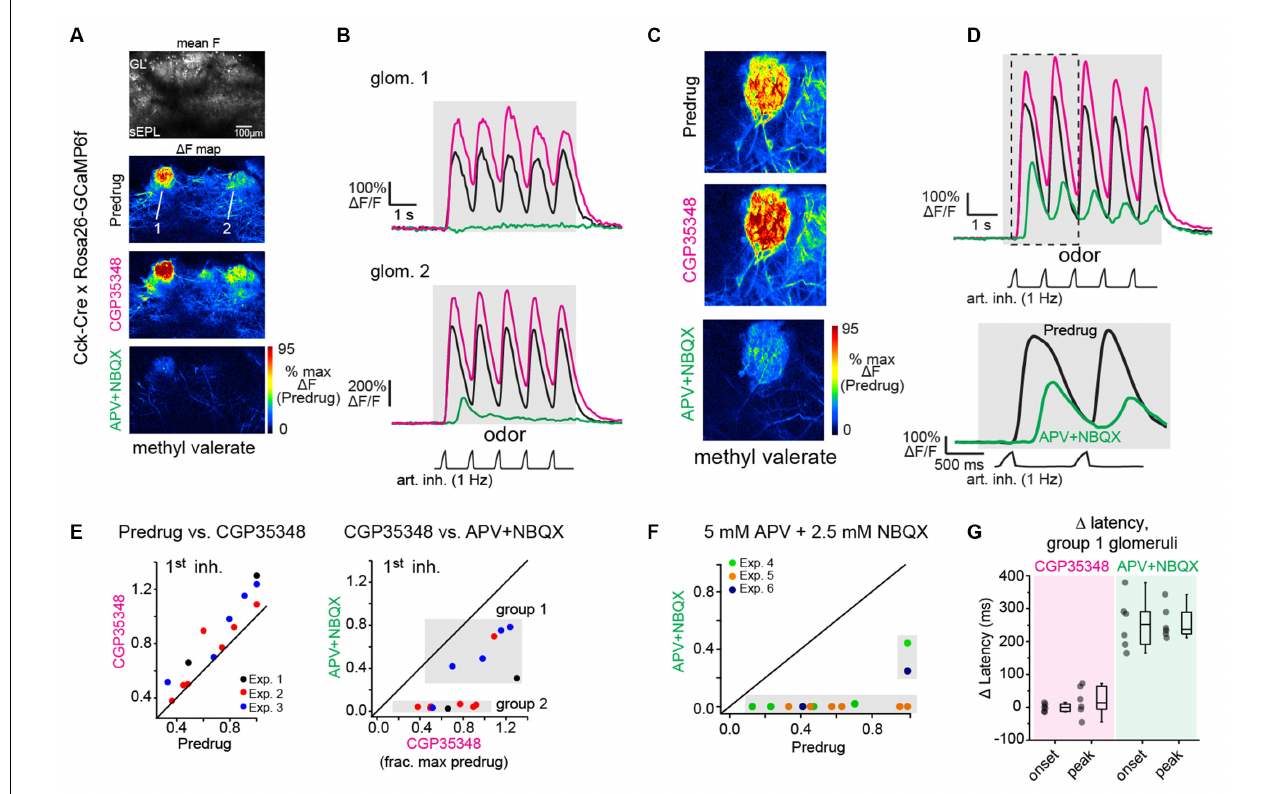
FIGURE 3 | Near-complete blockade of odorant-evoked excitation of CCK+ superficial tufted cells by APV+NBQX. (A) Odorant response maps of GCaMP6f signals imaged from CCK+ superficial tufted cells, taken across Predrug, CGP35348, and APV+NBQX conditions, scaled to Predrug response levels. (B) Response traces for the two glomeruli indicated in (A) , showing enhanced response amplitudes after application of CGP35348 and either elimination (top) or sharp reduction (bottom) in responses after subsequent application of APV+NBQX. Note that in ROI 1, the response after APV+NBQX is eliminated whereas, in ROI 2, the remaining response is present but delayed. Note also the two-fold difference in scale for ROI 2 due to differences in overall response magnitude. (C) Example of high-zoom imaging of GCaMP6f signals imaged from superficial CCK+ neurons innervating a glomerulus, with response maps in Predrug, CGP35348, and APV+NBQX conditions. (D) Traces showing odorant-evoked response from glomerular neuropil in (C) . CGP35348 increases response amplitudes. APV+NBQX decreases response amplitude, with delay in remaining signal relative to inhalation. Lower traces show the expansion of response to the first two inhalations of odorant, highlighting delayed GCaMP6f response after APV+NBQX. (E) Comparison of CCK+ GCaMP6f responses across CGP35348 and subsequent APV+NBQX conditions, imaged from 14 glomeruli in three OBs (two mice). Scatter plots show peak response to first inhalation of odorant in Predrug compared to CGP35348 condition (left) or CGP35348 and APV+NBQX conditions (right). Shaded regions in APV+NBQX vs. CGP35348 plot (upper right) indicate two groups of glomeruli defined by the magnitude of response reduction by APV+NBQX (see Text). Group 1 defines glomeruli whose responses persisted following APV+NBQX; group 2 defines glomeruli whose responses were eliminated. (F) Comparison of CCK+ GCaMP6f responses before (Predrug) and after higher concentrations of APV+NBQX (5 mM/2.5 mM), and without prior application of CGP35348. Separate experiments from (E) . Responses are fully blocked in 11 of 13 glomeruli, (three experiments). (G) Change in onset and peak latencies of CCK+ GCaMP6f response to the first inhalation of odorant after application of CGP35348 and APV+NBQX, for the six group one glomeruli shown in (E) . Response latencies for group 1 glomeruli are unchanged by CGP35348 application (left), but increase significantly after APV+NBQX application (right). Summary statistics, mean ± SD, paired t-test: CGP35348 vs. Predrug ∆ onset latency: − 0.5 ± 12 ms, p = 0.91; ∆ peak latency: 19 ± 45 ms, p = 0.34; APV+NBQX vs. CGP35348 ∆ onset latency: 255 ± 79 ms, p = 5 × 10 − 4 ; ∆ peak latency: 257 ± 51 ms, p = 6 × 10 − 5